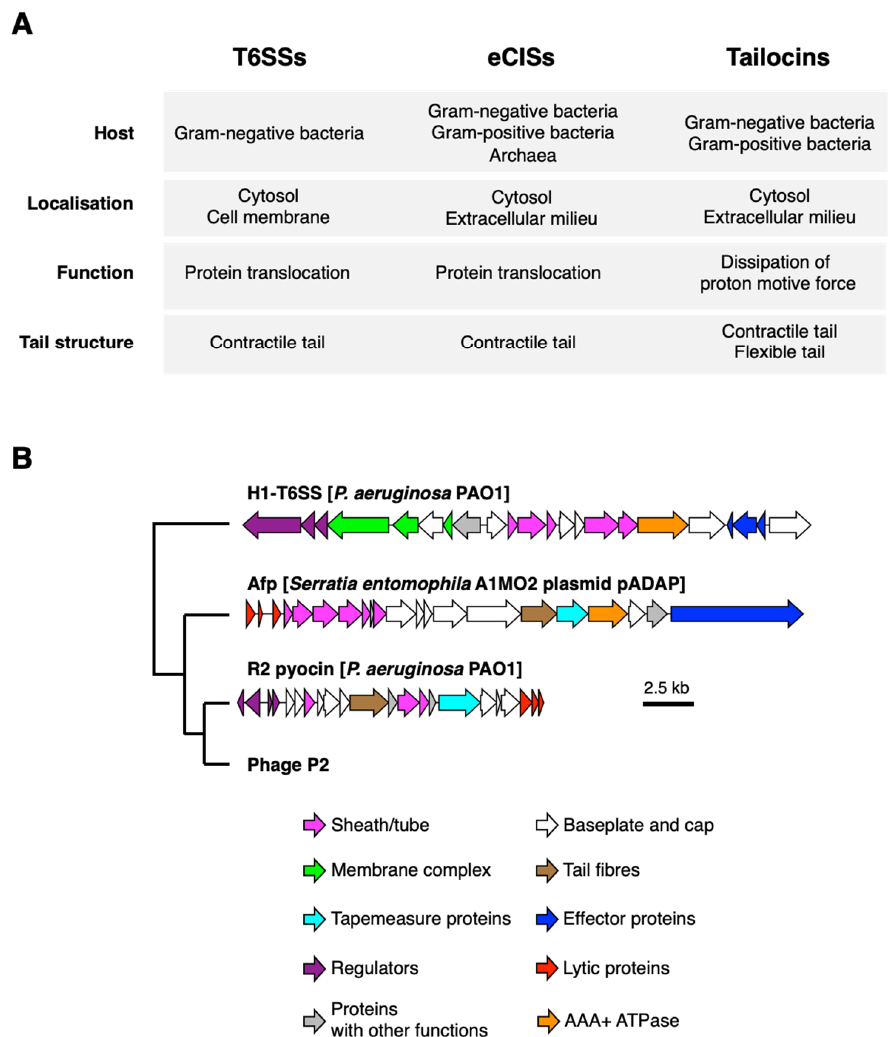
Figure 1. Features and genetic compositions of three classes of phage tail-like nanomachines. ( A ) Features of three classes of phage tail-like nanomachines are listed. ( B ) Genetic compositions of gene clusters encoding phage tail-like nanomachines, and their phylogenetic relationship are shown [10–12]. The phylogenetic relationship is based on that reported in a previous study